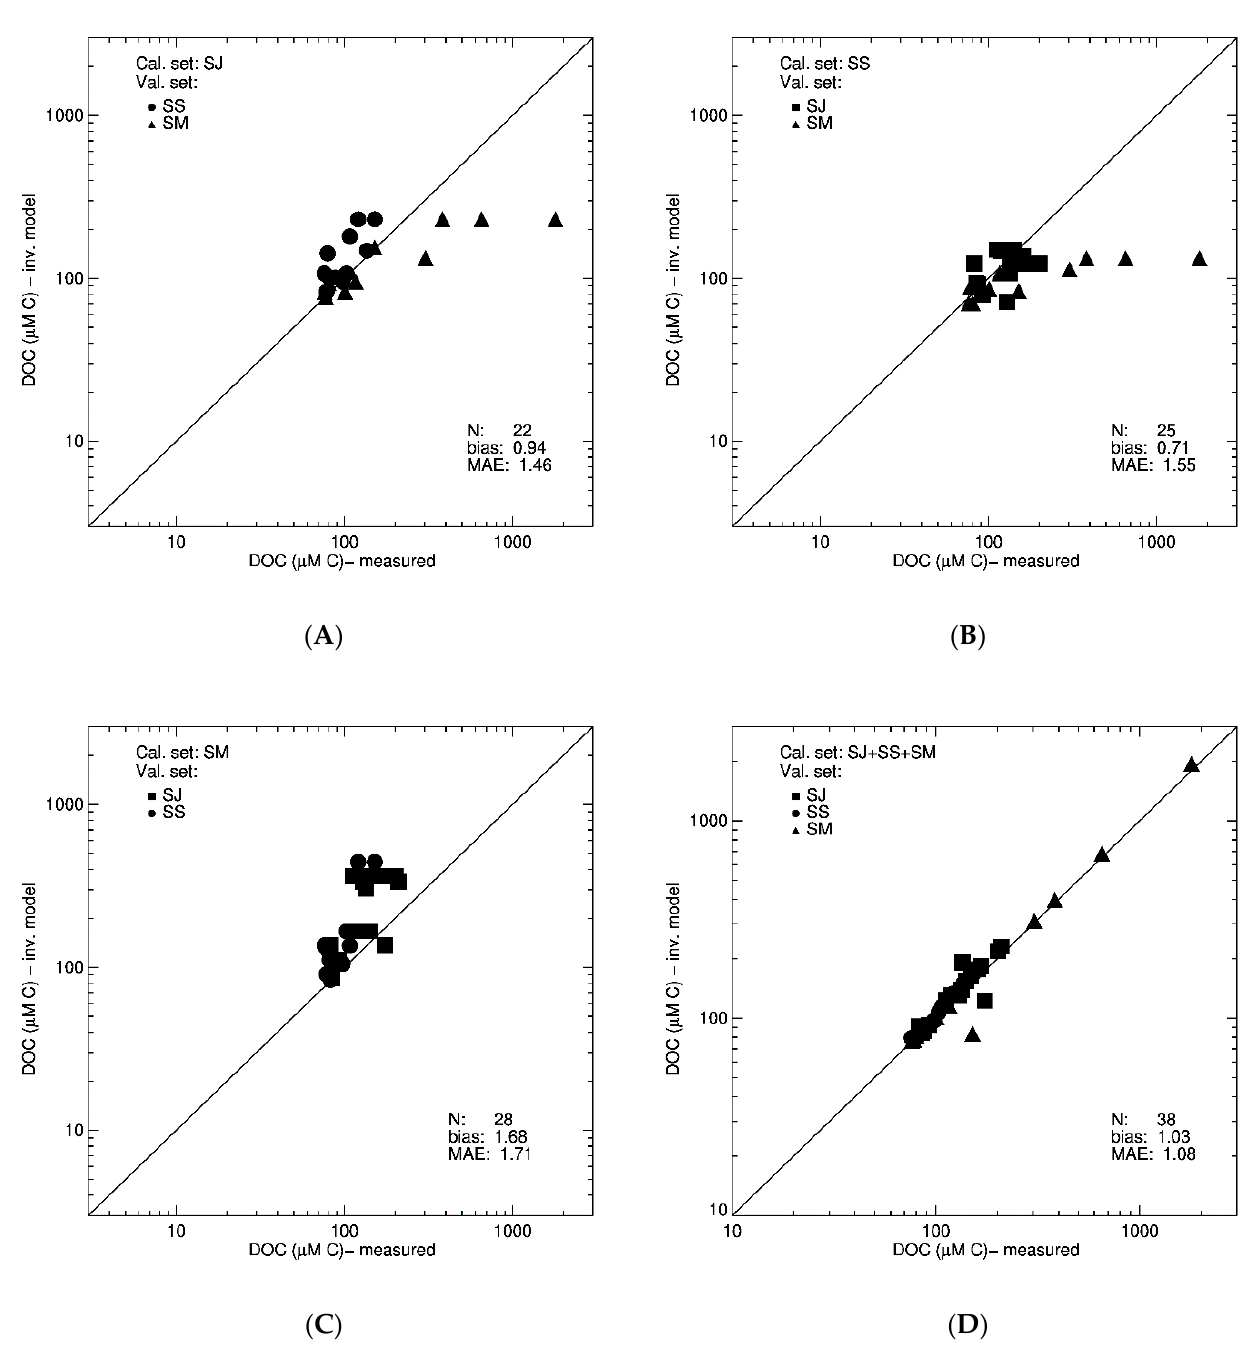
Figure 7. Performance of the optical inversion model for DOC retrieval with changing input members (Calibration set) included in the Sarawak spectral optical library. ( A ) Retrieval comparisons against SS and SM, ( B ) comparisons against SJ and SM, ( C ) comparisons against SJ and SS, and ( D ) comparisons when both the calibration and validation datasets included all available SIOP datasets in SSOL.